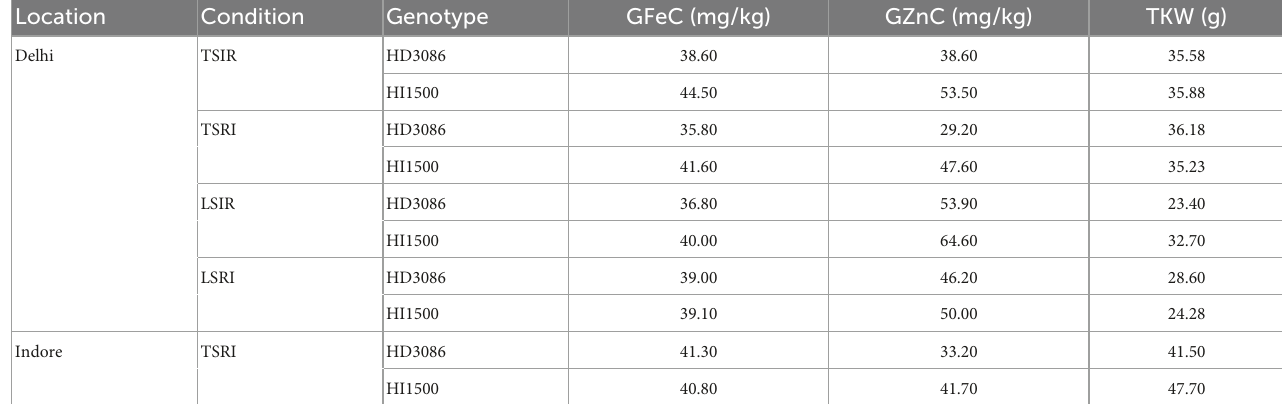
TABLE 2 Parental difference for the grain iron, zinc content, and thousand kernel weight.